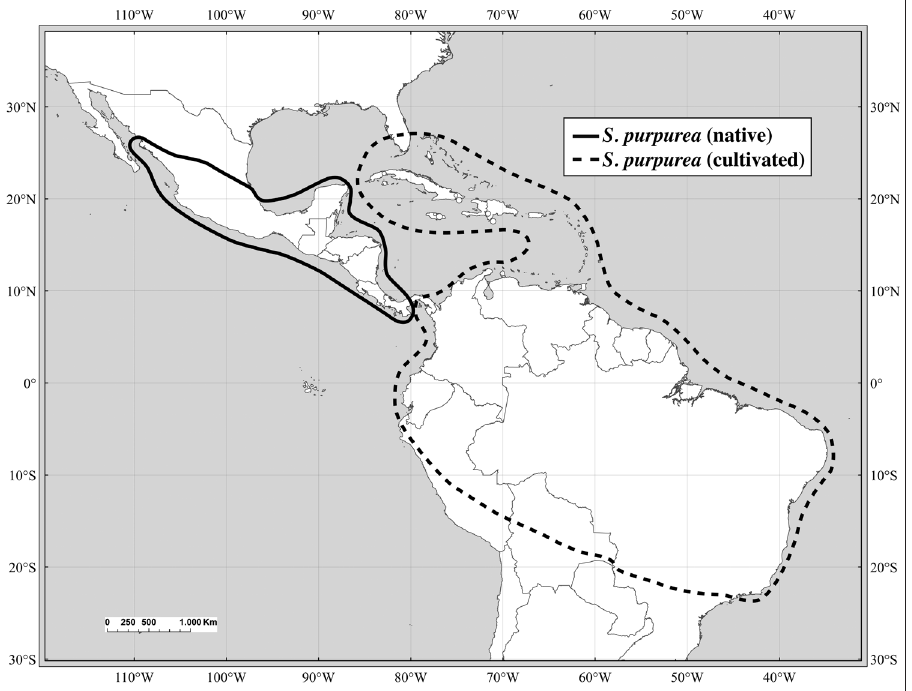
Figure 22. Distribution of Spondias purpurea.